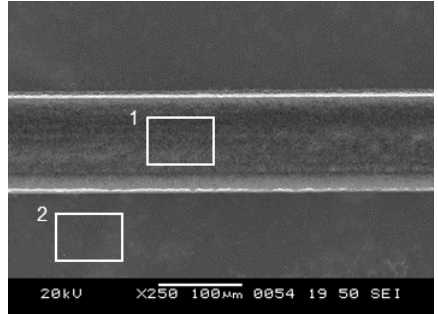
Figure 11. Analysis was conducted of the square areas outlined in white. Square 1 indicates the bottom surface of a channel and square 2 indicates the glass surface.